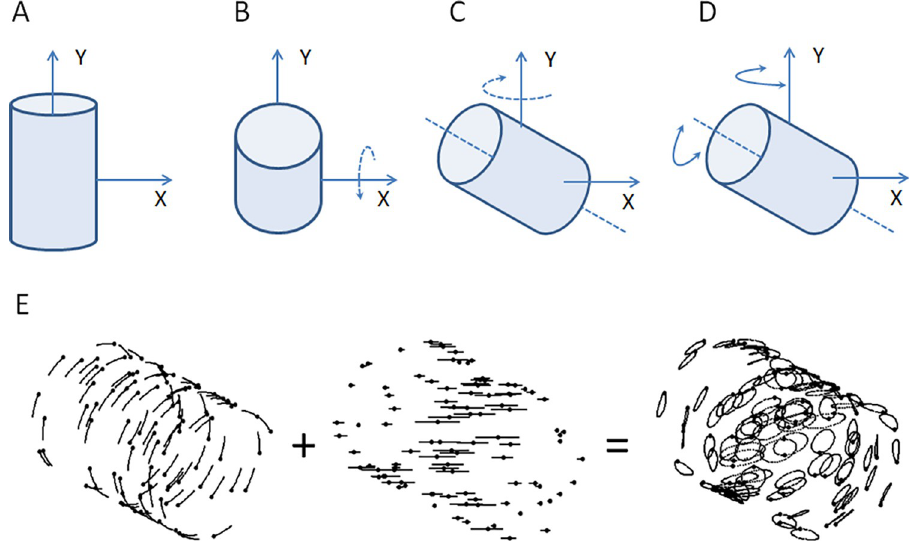
Fig 2. Construction of the SFM cylinder. Dots were randomly spread on the surface of an invisible cylinder. (A) Initially, dots were spread on the cylinder with its main axis oriented along the vertical y-axis. (B) To obtain the initial orientation of the cylinder it was slanting around the x-axis (C) and then tilted around the y-axis. (D) From the initial orientation, small steps of rotation around the cylinder main axis and around the vertical y-axis between each frame created the wiggling motion. (E) Adding these two oscillatory rotation components created elliptic motion paths of the individual dots, here visualised as motion strikes obtained from a long exposure.